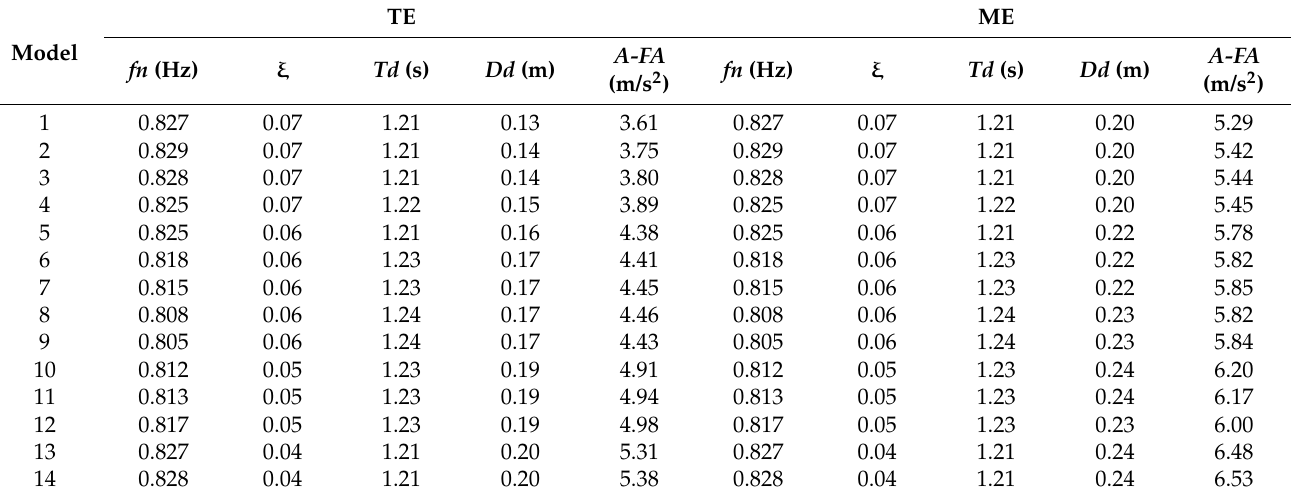
Table 5. FA results for Scenario